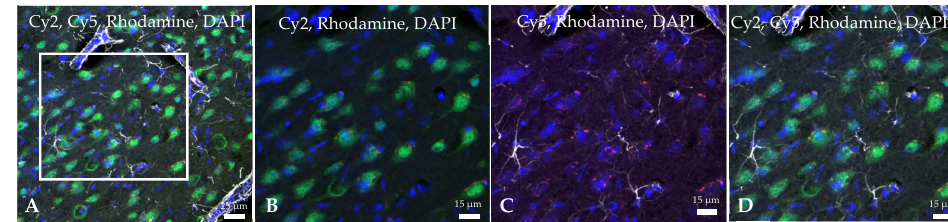
Figure 4. Confocal microscopy images from the infarcted zone of MCAO animals taken 24 h after the systemic injection of the Ngb-NPs. A ) Cy2 green fluorescence represents Ngb. B ) Rhodamine red fluorescence detects NPs. C ) DAPI blue fluorescence marks cell nuclei. D ) Merge image showing the colocalization of Ngb and NPs inside the nervous cells. Ngb attached to NPs appears in yellow, due to green and red merge.